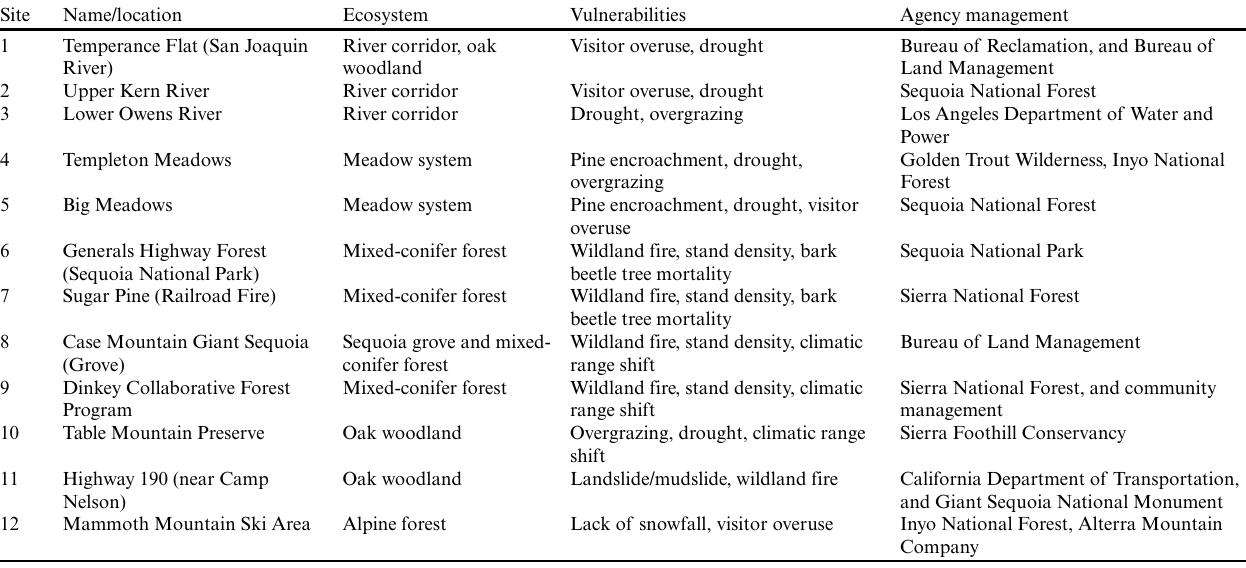
Table 1 . Study site